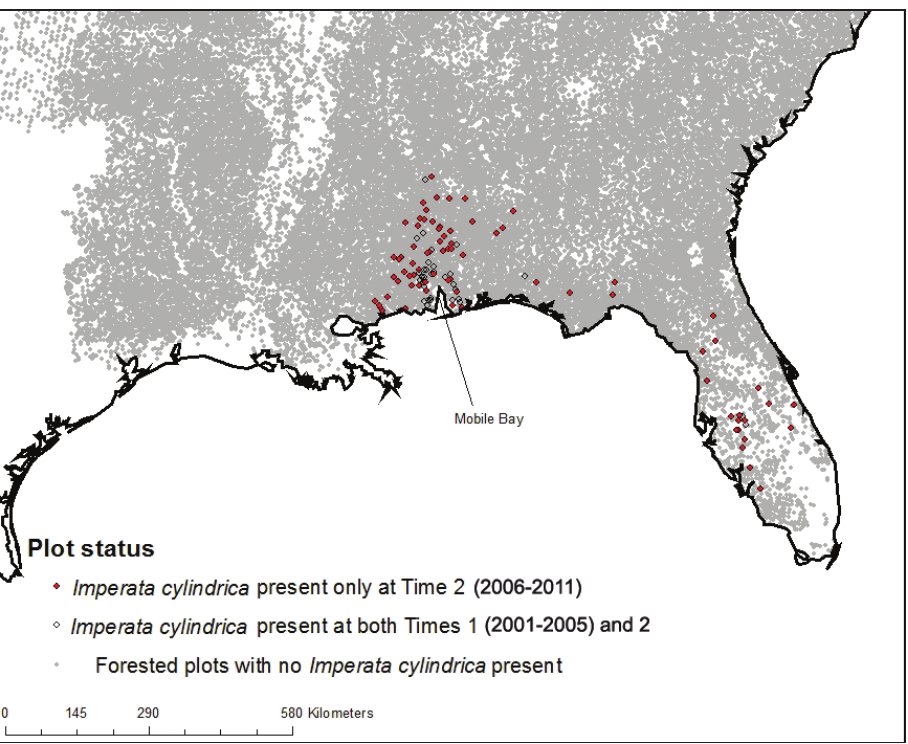
Figure 2. Spatial progression of Imperata cylindrica based on multiple measurements of forested plots from the FIA sampling grid. Time 1 represents data collected from 2001 to 2005 and Time 2 from 2006 to